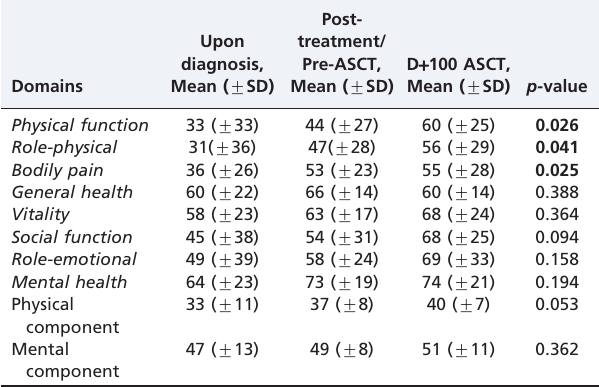
Table 2 - Analysis of variance (ANOVA) comparing the three groups according to the SF-36 questionnaire.